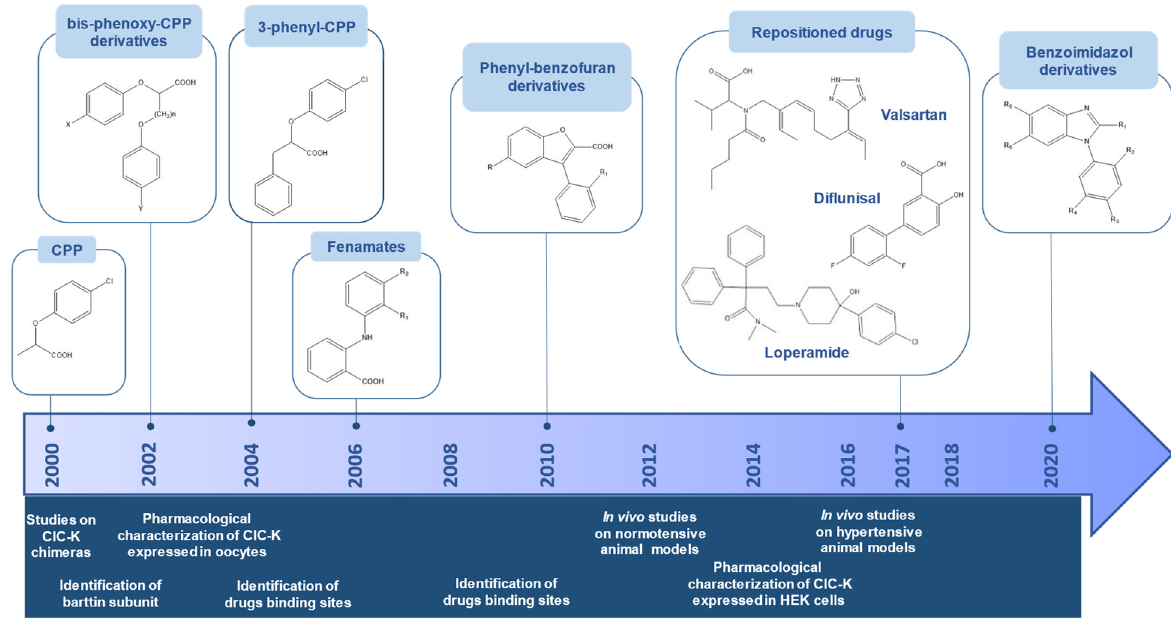
Figure 4. Picture describing the discovery of ClC-K ligands in the last 20 years.